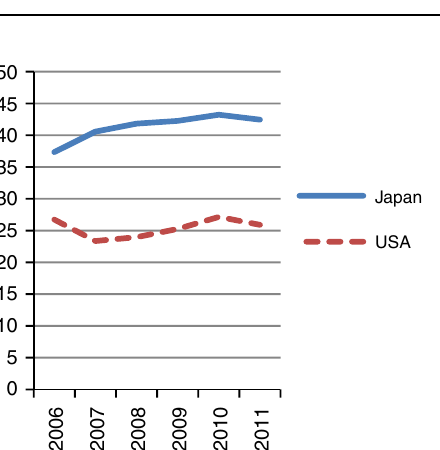
Figure 1. Annual